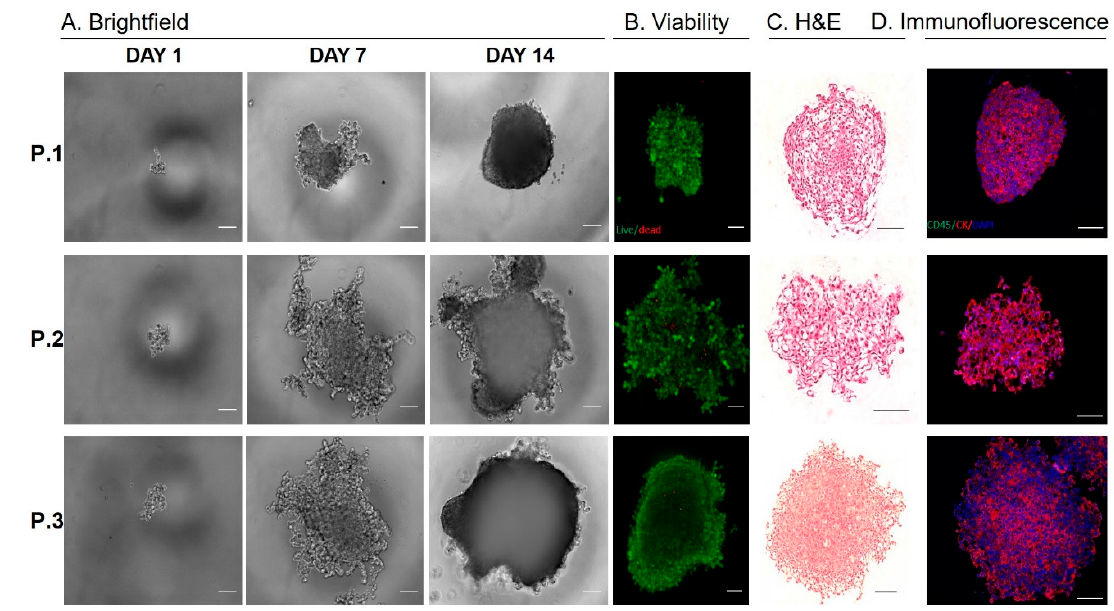
Figure 4. Characterizing CTC-derived spheroid cultures. ( A ) Pancreatic CTCs were seeded on hanging drop array plates with 10 cells/drop. Alamarblue fluorescence was used to monitor droparrayplateswith10cells / drop. Alamarbluefluorescencewasusedtomonitorviability / proliferation viability/proliferation (expressed as a fold increase at Day 7 and Day 14, compared to Day 1). ( B ) (expressed as a fold increase at Day 7 and Day 14, compared to Day 1). ( B ) Representative images of Representative images of live/dead staining using calcein and ethidium homodimer at Day 14, live / dead staining using calcein and ethidium homodimer at Day 14, indicate high viability within indicate high viability within pancreatic CTC spheroids. ( C ) Representative images H&E of spheroids. pancreatic CTC spheroids. ( C ) Representative images H&E of spheroids. ( D ) Immunoflourescence ( D ) Immunoflourescence staining for cytokeratin (red), CD45 (green) and DAPI (blue) on spheroids. staining for cytokeratin (red), CD45 (green) and DAPI (blue) on spheroids. (Scale bar = 100 µ (Scale bar = 100 μ m).